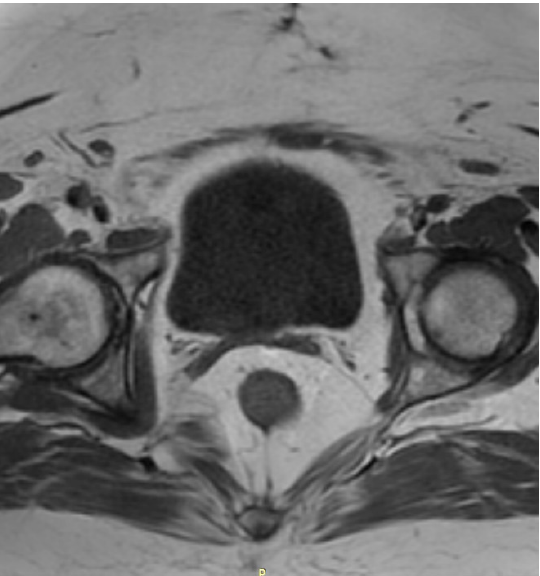
Figure 3. A postoperative MRI of the pelvis in axial projection, performed 18 months after the Wertheim–Meigs operation. A vaginal stump is visible. No signs of recurrence are